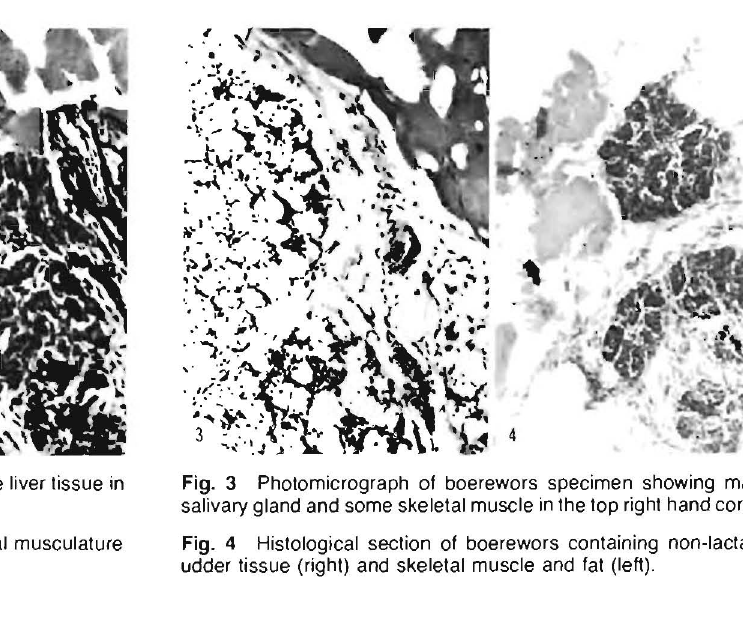
Fig. 1 Photomicrograph showing fatty changes in the liver tissue in boerewors. Fig. 2 Histological section of boerewors with skeletal musculature (top) and splenic tissue (bottom).